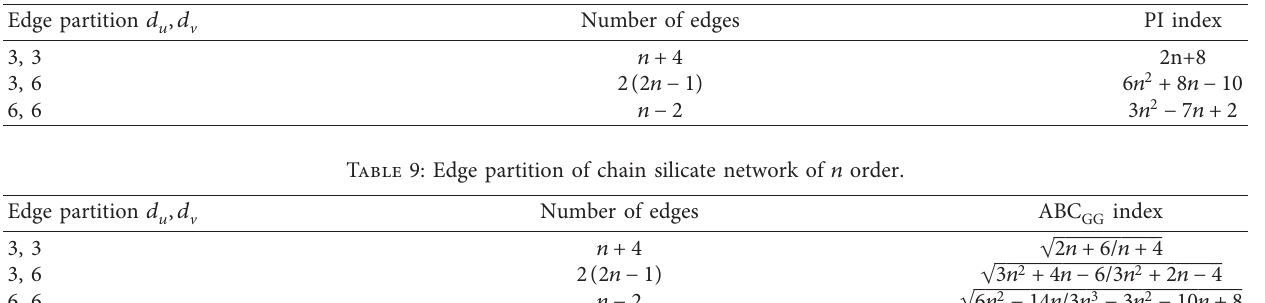
Table 8: Edge partition of chain silicate network of n order.